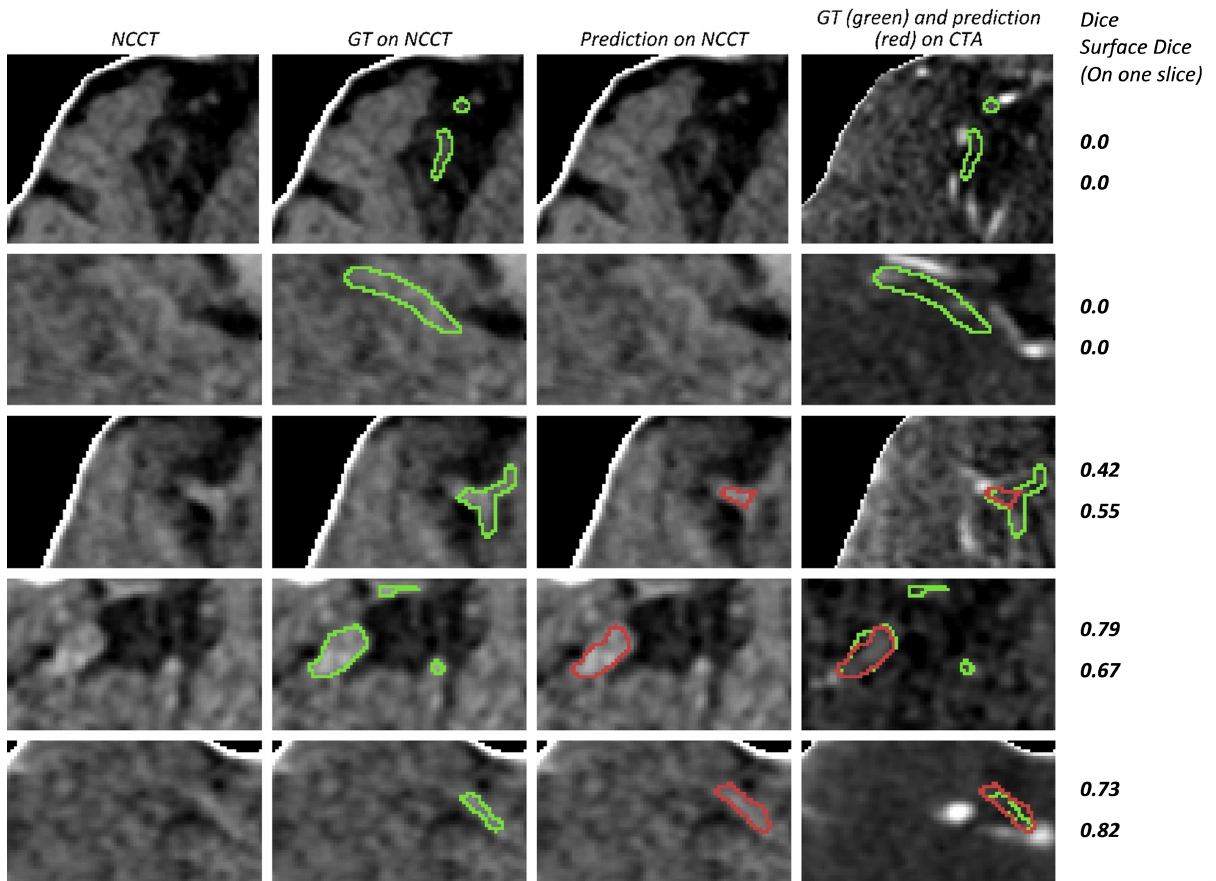
Figure 10. Examples of cases with segmentation errors or a low Dice score. The bounding box is used to limit the scan area. Since the bounding box is three-dimensional, only the axial slice with the largest ground truth surface area is depicted. The boundaries of the ground truth annotation (GT) and segmentation prediction (prediction) are shown in green and red, respectively. Dice and surface Dice for the displayed 2D slice are shown at the right side for each row. The top-most row shows a missed case (Dice = 0). The second row shows a case with a non-zero overall Dice score where the network does not segment the thrombus in the presented axial